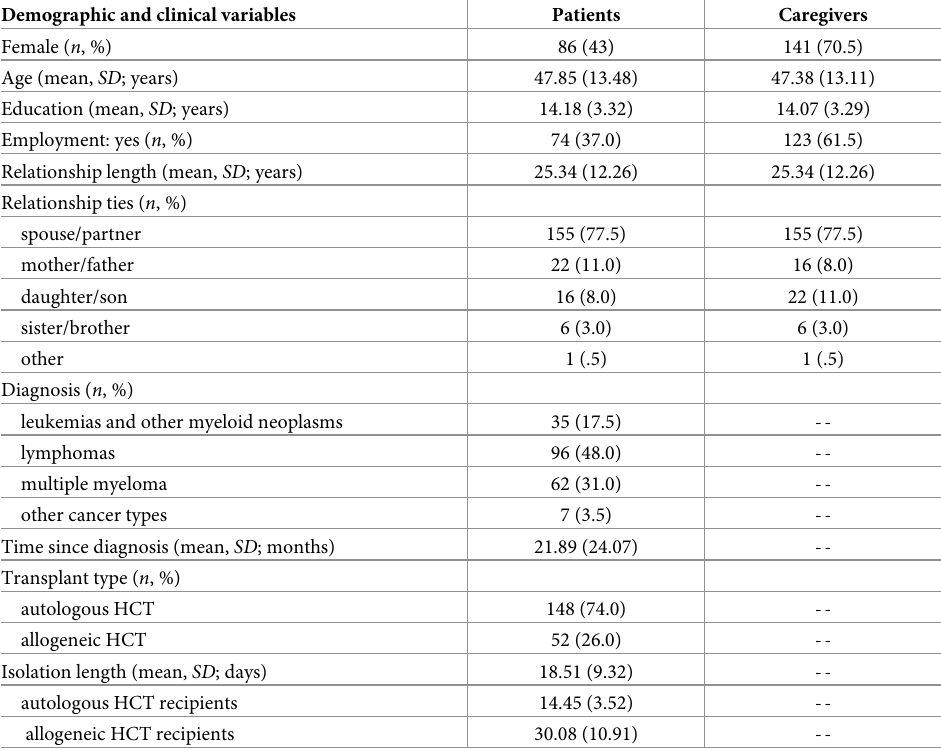
Table 1. Characteristic of patient-caregiver dyads ( N =